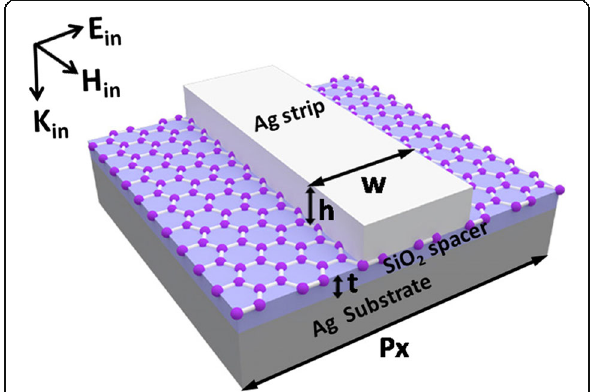
Fig. 1 Schematic of the building block of metamaterials. Geometrical parameters: the period p x along the x -axis direction, the thickness t of the silica spacer, the width w , and the height h of the silver